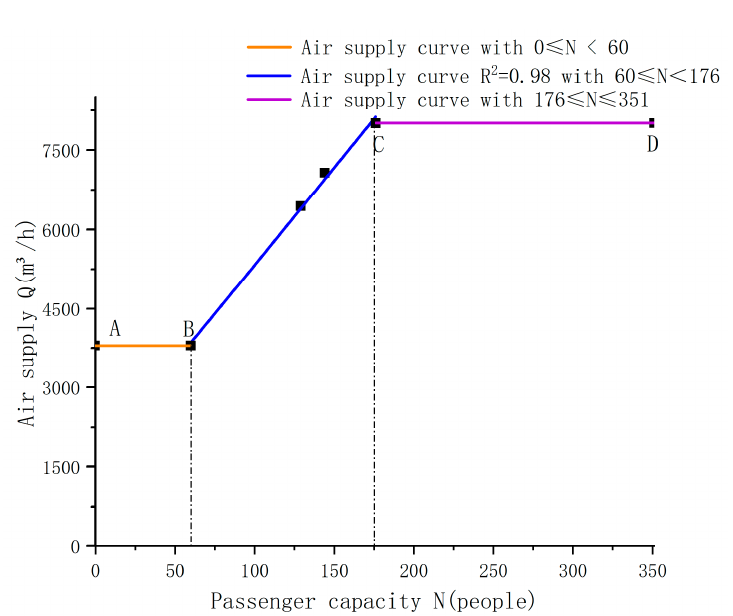
Figure 1. The air supply volume curve based on the cooling and fresh-air-volume requirements.